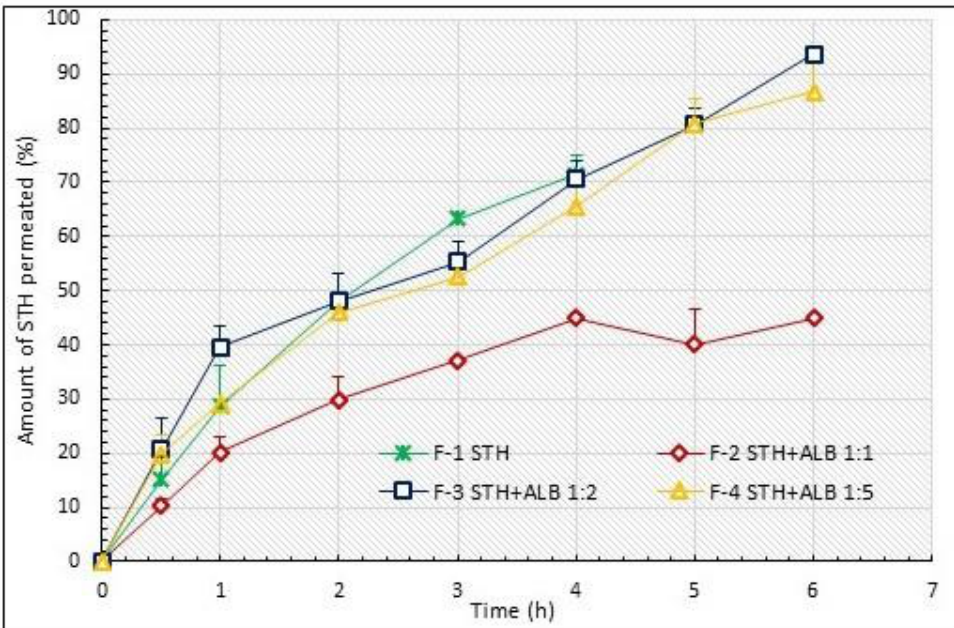
Figure 1. STH permeation through Spectra/Por ® Dialysis Membrane synthetic cellulose membrane with 100 kDa pore size; F-1 — STH 0.1%, F-2 — STH /ALB 1:1 (0.1%:0.1%), F-3 — STH /ALB 1:2 (0.1%:0.2%), F-4 — STH /ALB 1:5 (0.1%:0.5%), n = 6.